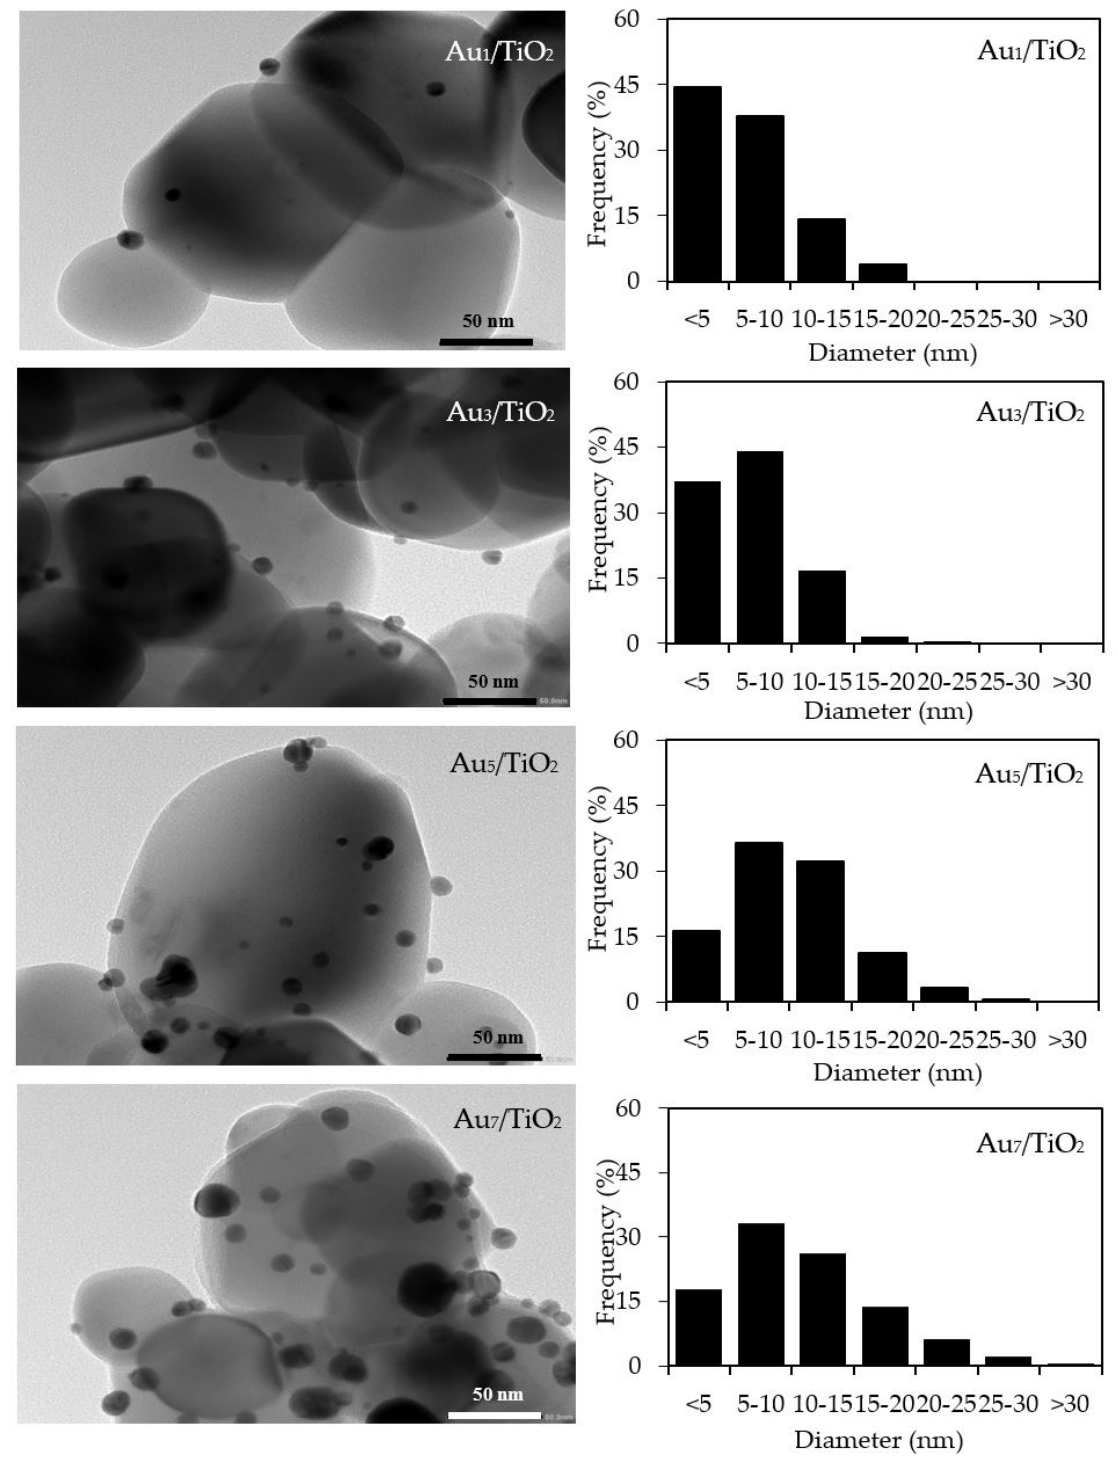
Figure 3. ( Left ) Representative TEM images of the different Au x /TiO 2 photocatalysts, and ( Right ) the derived Au nanoparticle (NP) size distribution on the surface of the TiO 2 .